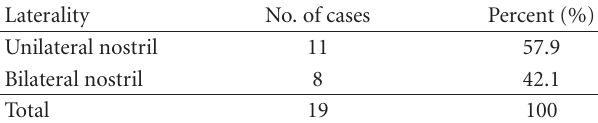
Table 2: Site of epistaxis.